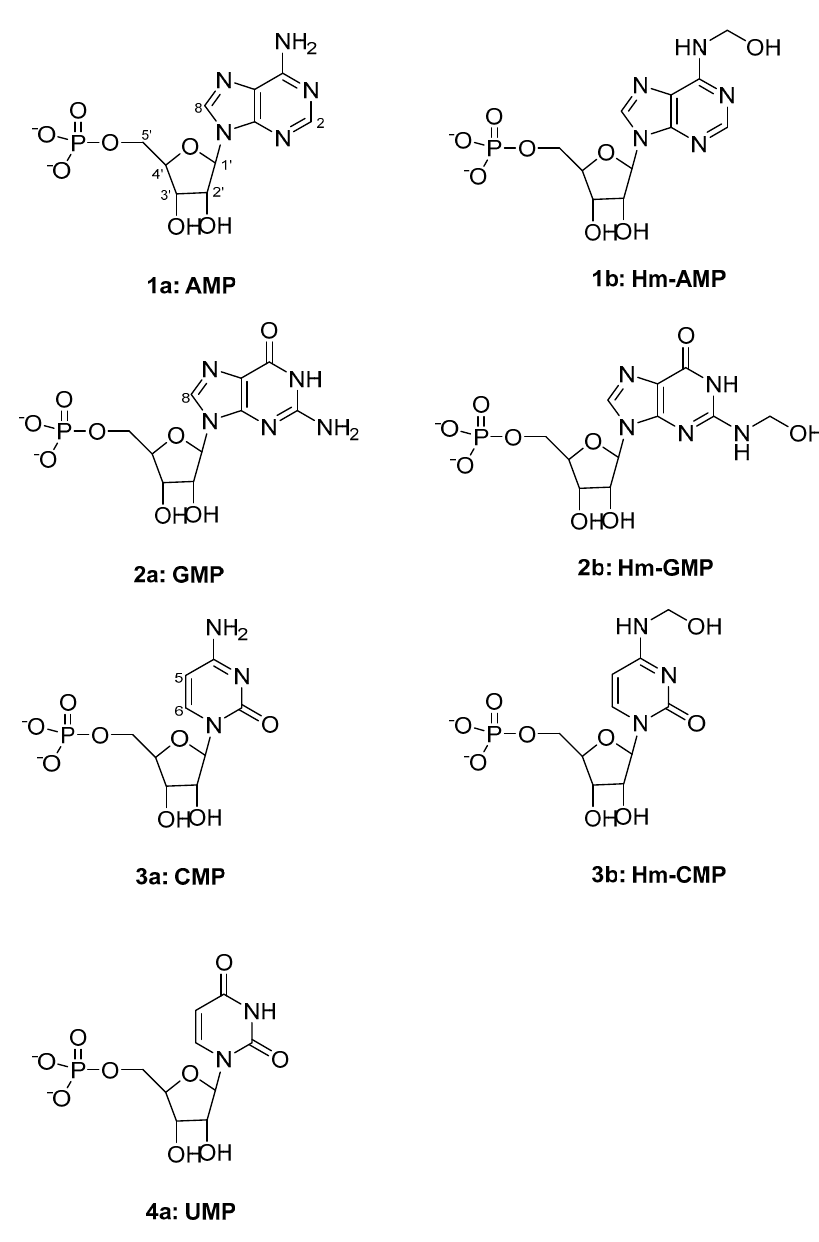
Figure A1. Structure of mononucleotides 1a – 4a and hydroxymethyl adducts 1b – 3b.